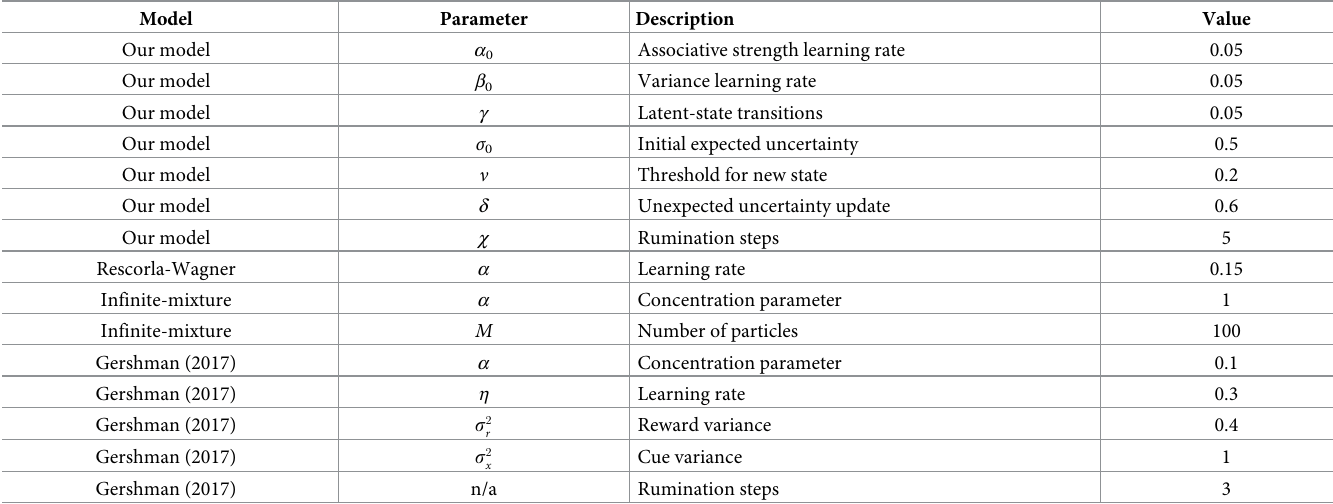
Table 3. Fixed set of parameters used for all simulated